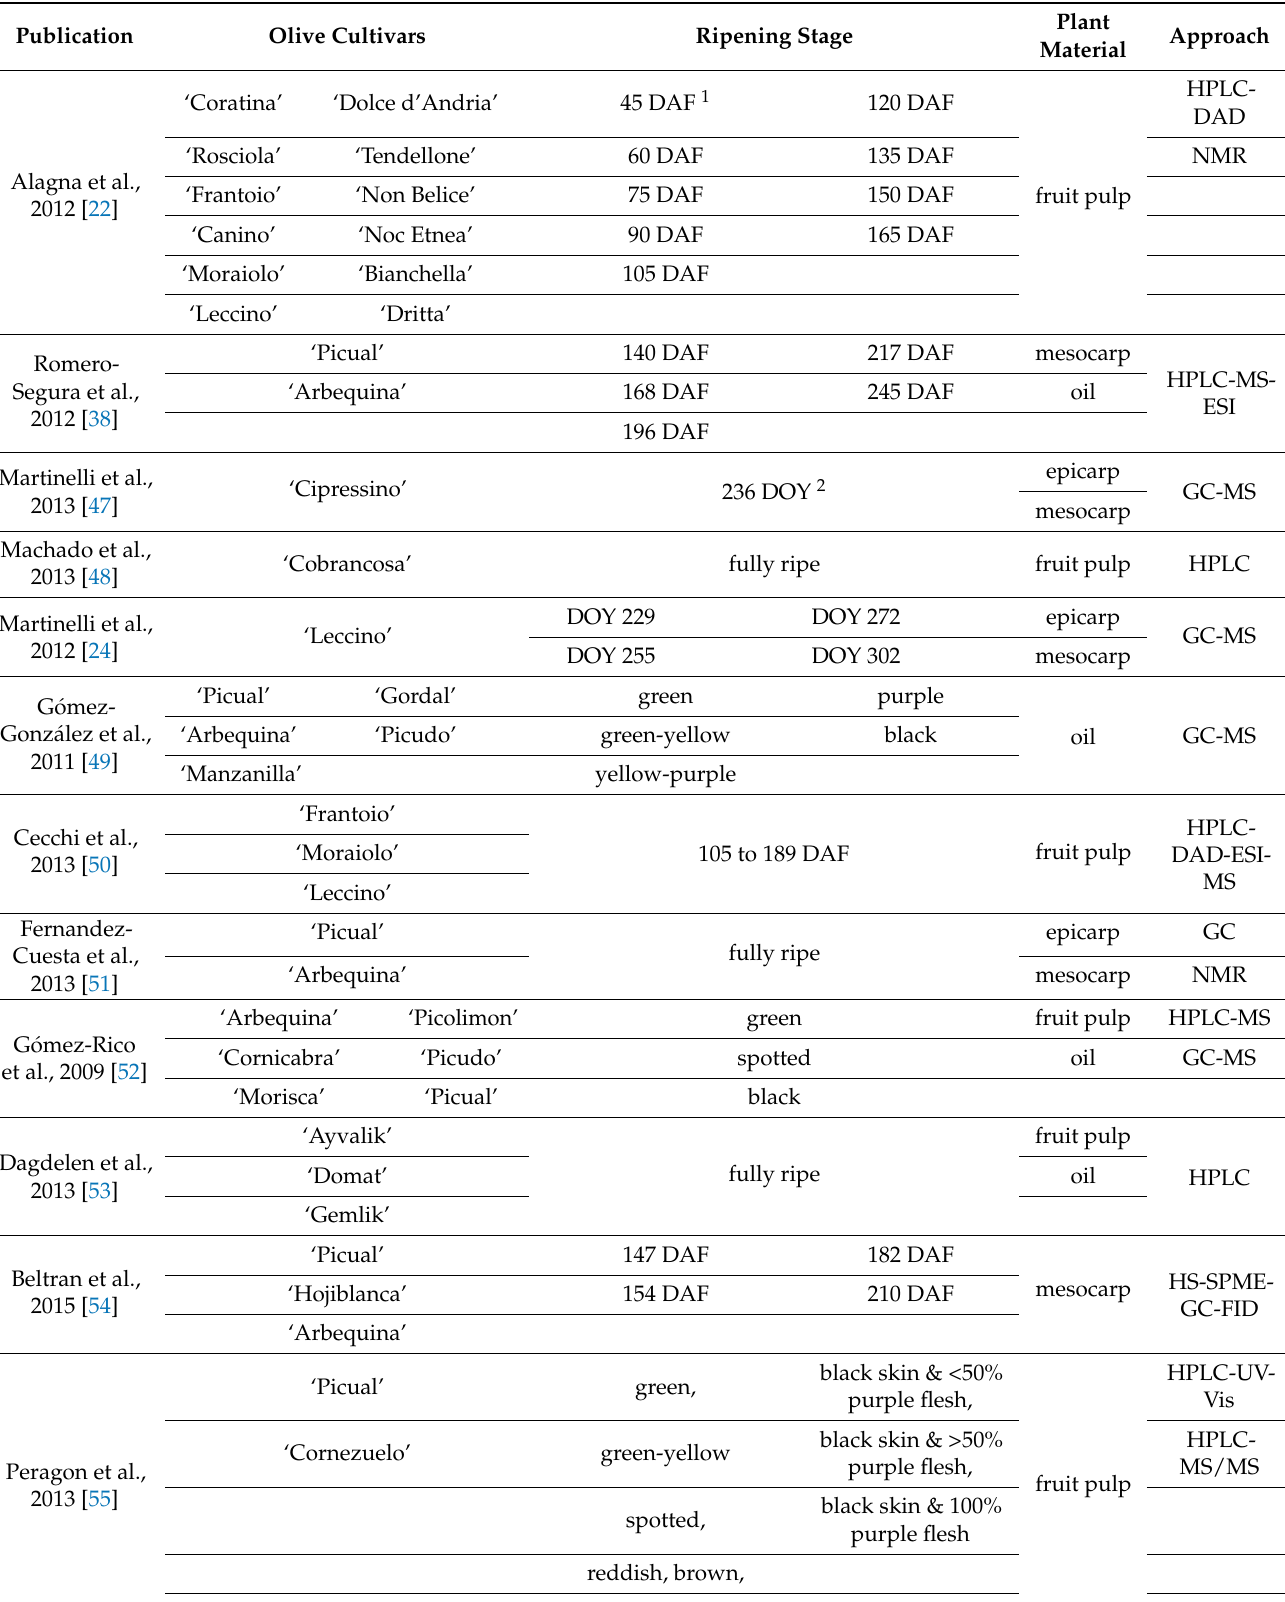
Table 4. Analytical techniques that have been used in recent literature, providing a great amount of metabolomic data in order to interpret olive’s ripening complex regulation and